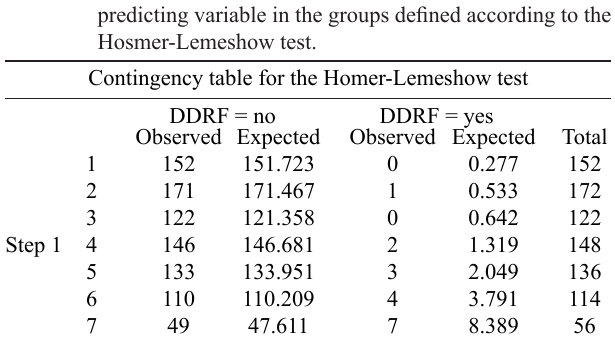
Table 6. Crossing of EuroSCORE with RTI